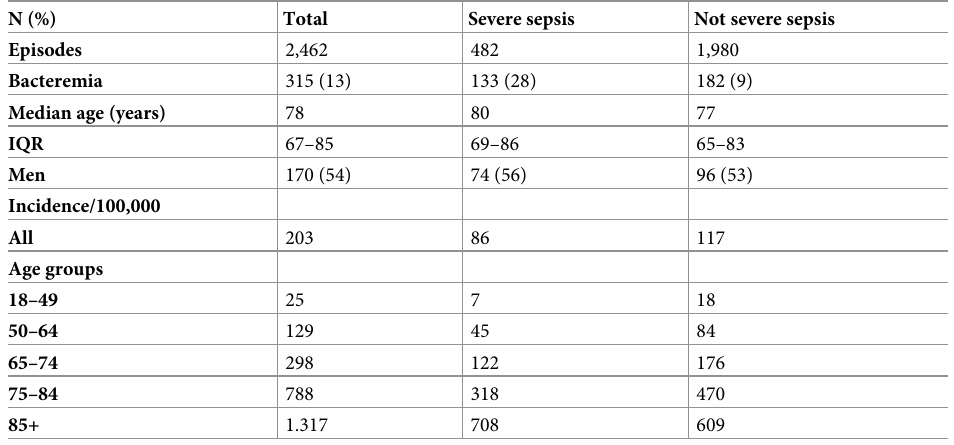
Table 5. Characteristics of 315 consecutive episodes of clinically relevant bacteremia in blood cultures among 2,462 1 adult admissions for suspected community onset bacterial infection in Sweden. N